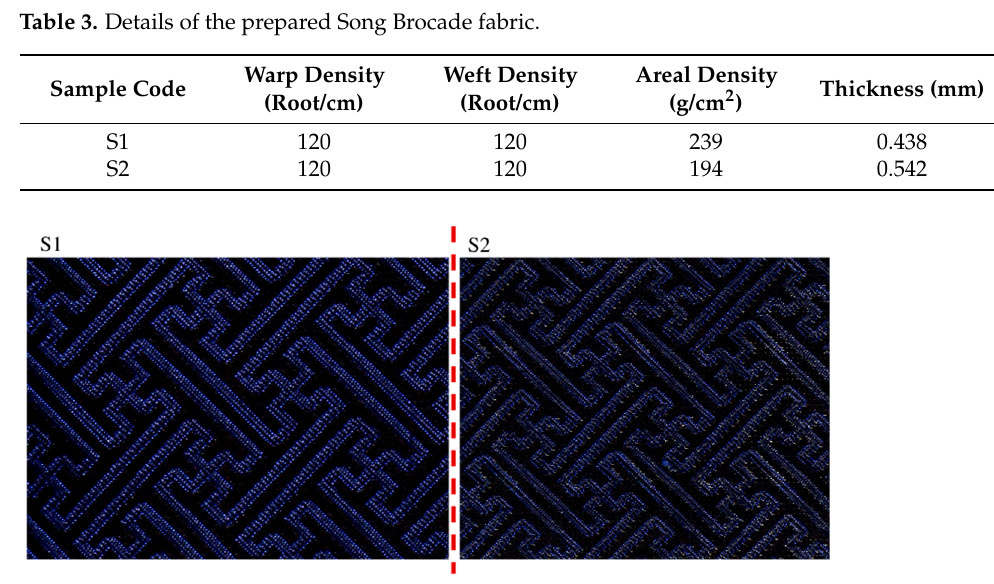
Figure 1. Fabric weaves and structure of the Song Brocade fabric (schematic cross-section).